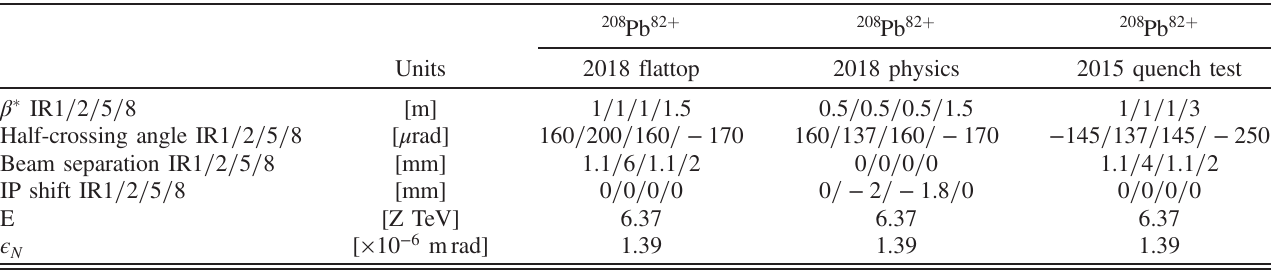
TABLE I. B1 2015 and 2018 208 Pb 82 þ main optics and beam run parameters at flattop and physics static points of the LHC cycle.